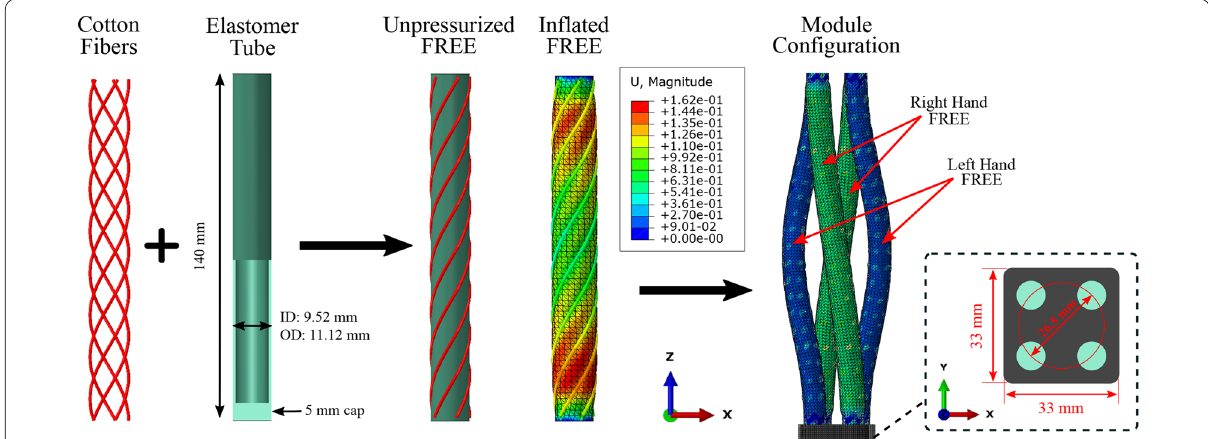
Fig. 6 Finite element model of FREE in Abaqus. The elastomer tube and cotton fibers were modeled as deformable geometries (left). The assembly of these constituents into a single FREE is shown before and after pressurization (middle). Note that the FREE is fixed at both ends and produces no rotation or elongation under these boundary conditions. The module configuration of four FREEs and their arrangement as seen in a top view of the end-effector is shown on the